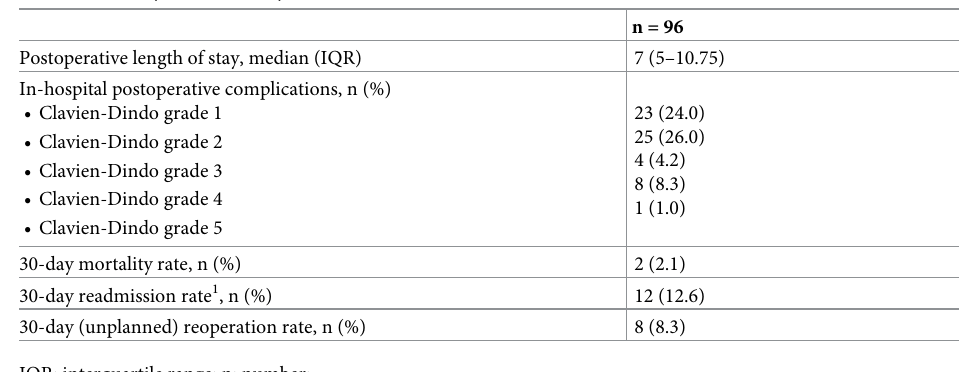
Table 3. Primary and secondary